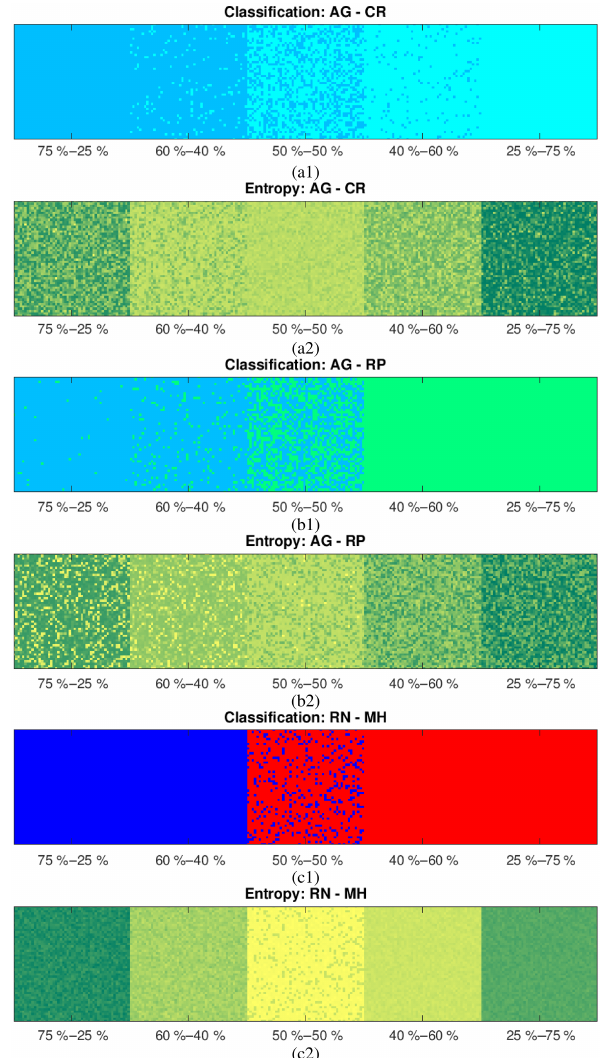
Figure 8. Classification (1) and entropy (2) for different combina- tions of synthetically produced mixtures: (a) aggregates–crystals, (b) aggregates–rimed ice particles and (c) rain–melting hail.